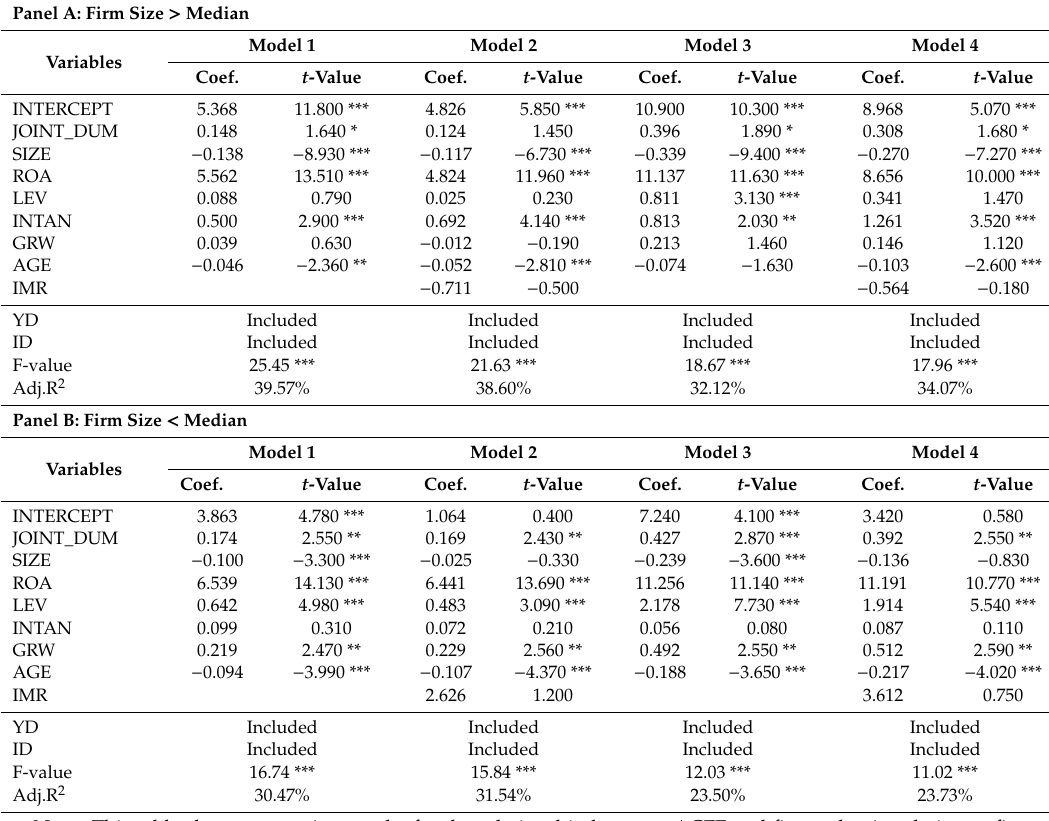
Table 12. Analysts’ cash flow forecast issuance and firm